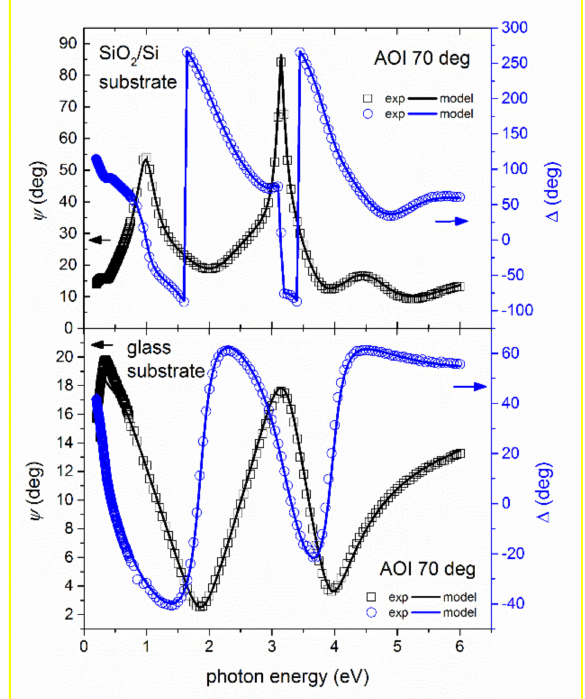
Figure 1. Measured values of ψ (squares) and ∆ (circles) as a function of photon energy, E , for In 0.4 Zn 0.25 Sn 0.35 O 1.5 (Sn-rich indium zinc tin oxide (IZTO)30) sample in a wide spectrum for samples as-deposited onto SiO 2 /Si substrate (upper part) and onto glass substrate (lower part). The best fit for the angle of incidence 70 ◦ is shown by solid